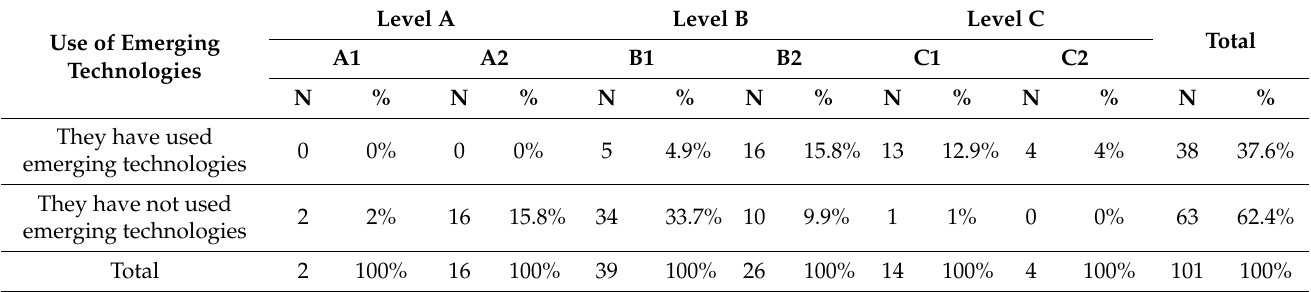
Table 3. Relationship between levels of digital competence and the use of emerging technologies.